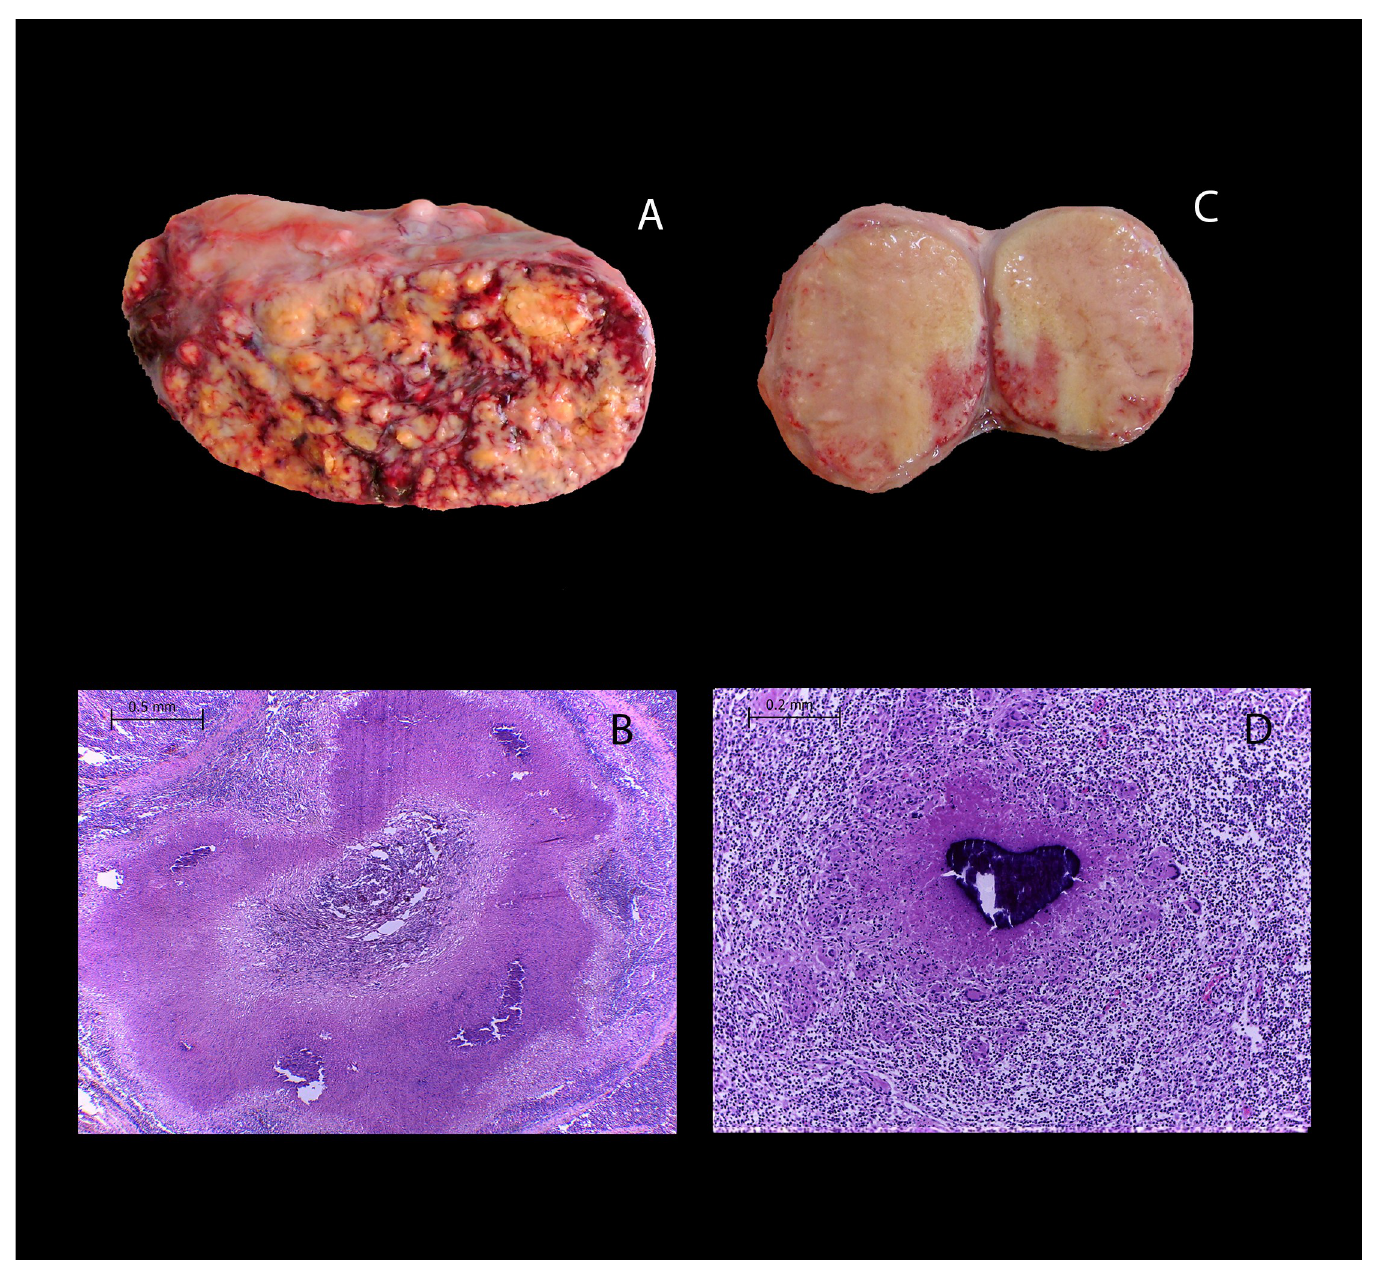
Fig 1. Extensive lesions suggestive of tuberculosis were observed in lymph nodes from calves naturally infected with M . bovis and compared to lesions found in adult cattle. (A) Mediastinal lymph node with severe granulomatous lymphadenitis and (B) H&E, 40x showing a granuloma encapsulated by connective tissue and abundant necrosis and mineralization from a 3-year-old Holstein-Friesian dairy cow. (C) Mediastinal lymph node with extensive areas of caseous necrosis and microhemorrhages and (D) H&E, 40x showing a granuloma without connective tissue and abundant necrosis and mineralization from a one-month-old Holstein- Friesian